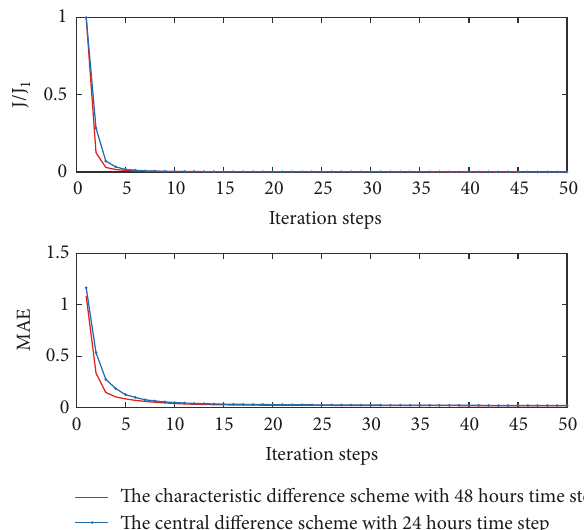
Figure 6: The descending curves of the relative magnitude of the cost function 𝐽/𝐽 1 and the mean absolute error (MAE) of observation points using CFD and CDS with different time